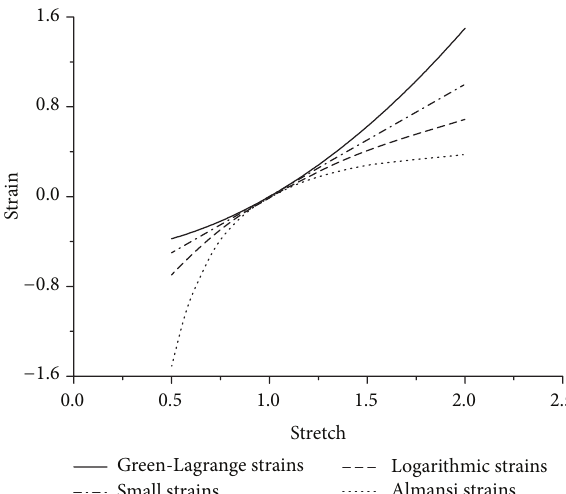
Figure 5: Shear stress 𝜏 12 along shear strain 𝛾 .